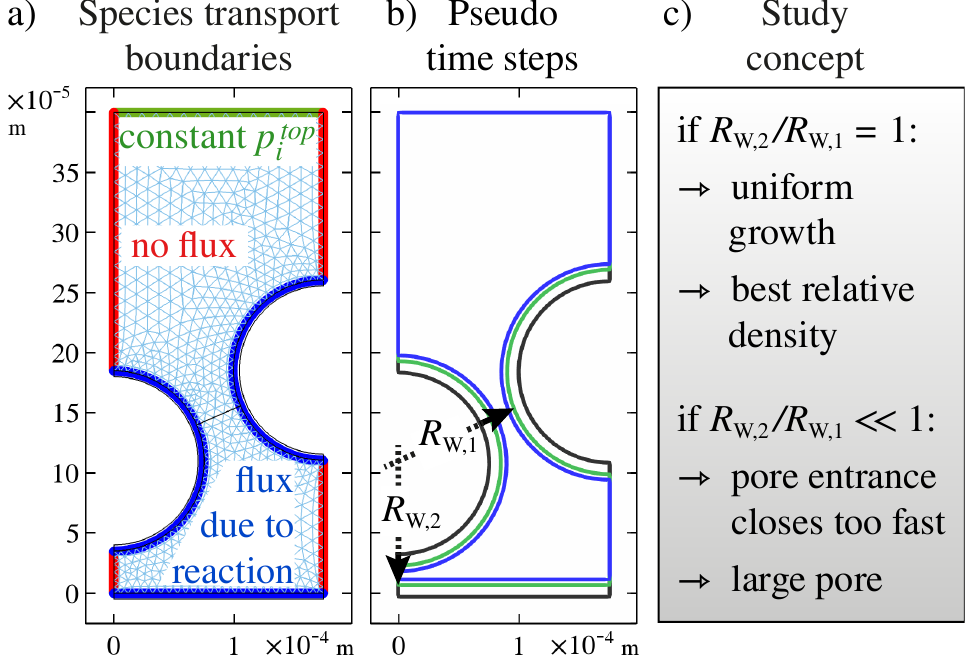
Figure 4. Setup and concept for the parameter study regarding the infiltration of a single symmetric pore adjacent to two W fibers. ( a ) Micro-scale model boundaries for species transport. ( b ) Visual- ization of three different geometries (pseudo time steps) of the stationary W infiltration simulation resulting in (shrinking) pore entrance sizes of 39.8, g20.9, and b11.4 µm. The positions of R W,1 and R W,2 are also shown. The quotient ( R W,2 divided by R W,1 ) is used as an evaluation quantity for the coating uniformity. The meaning of the possible results for this evaluation quantity is summarized in ( c ), the study